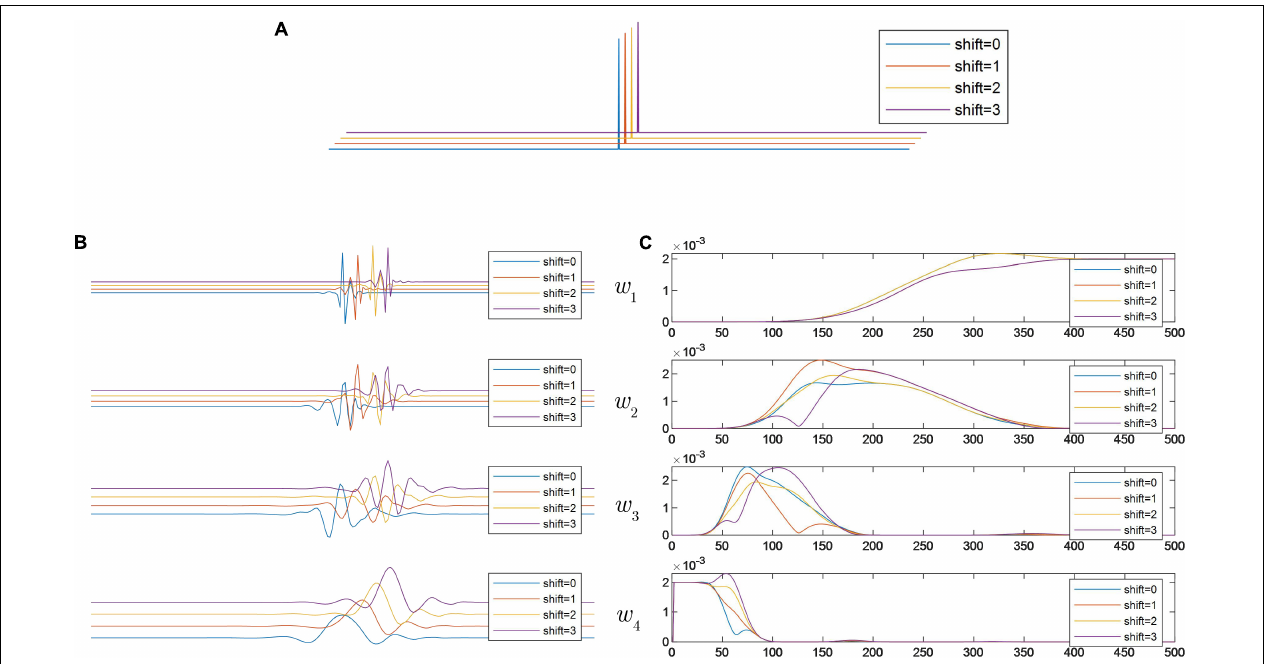
FIGURE 2 | (A) Shifted versions of discrete delta impulse function; (B) time domain waveforms of wavelet subspaces generated by DWT; and (C) the FFT spectra of the decomposed wavelet subspaces generated by DWT.